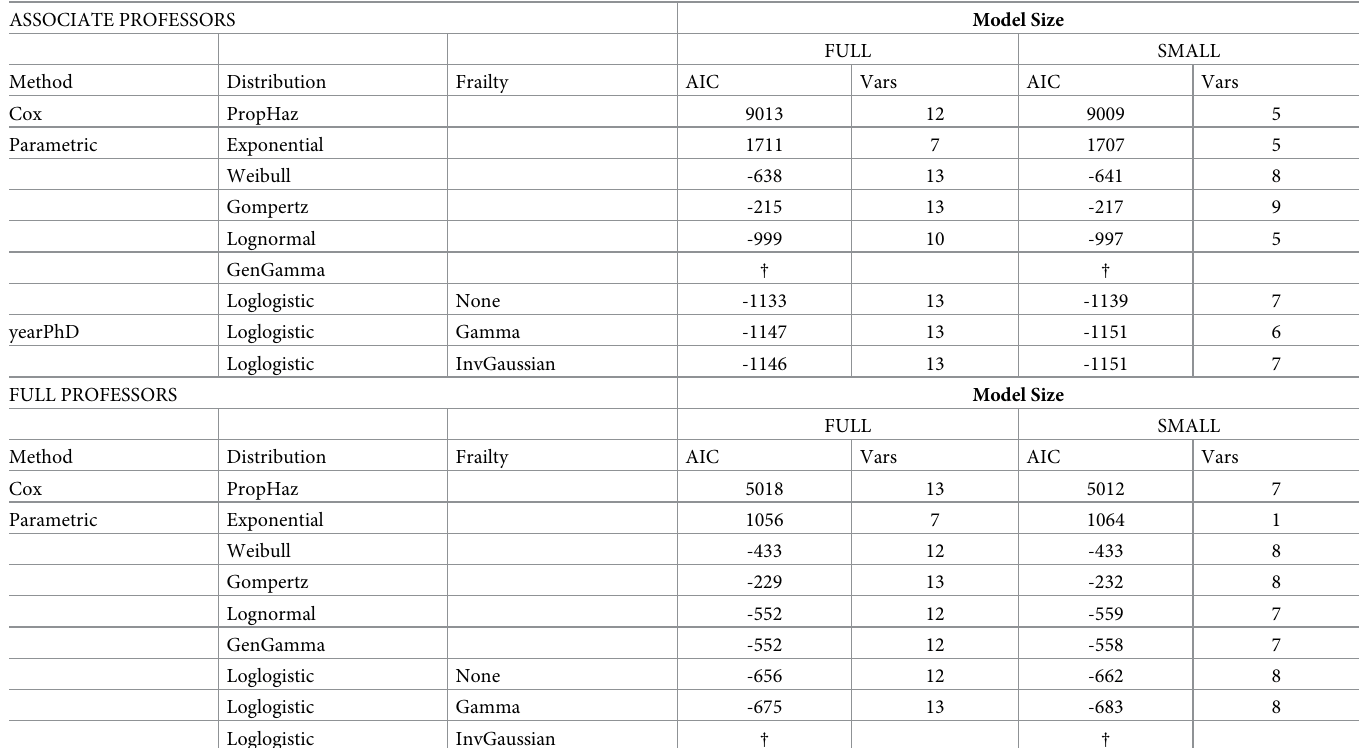
Table 2. Selection of hazard function for parametric survival